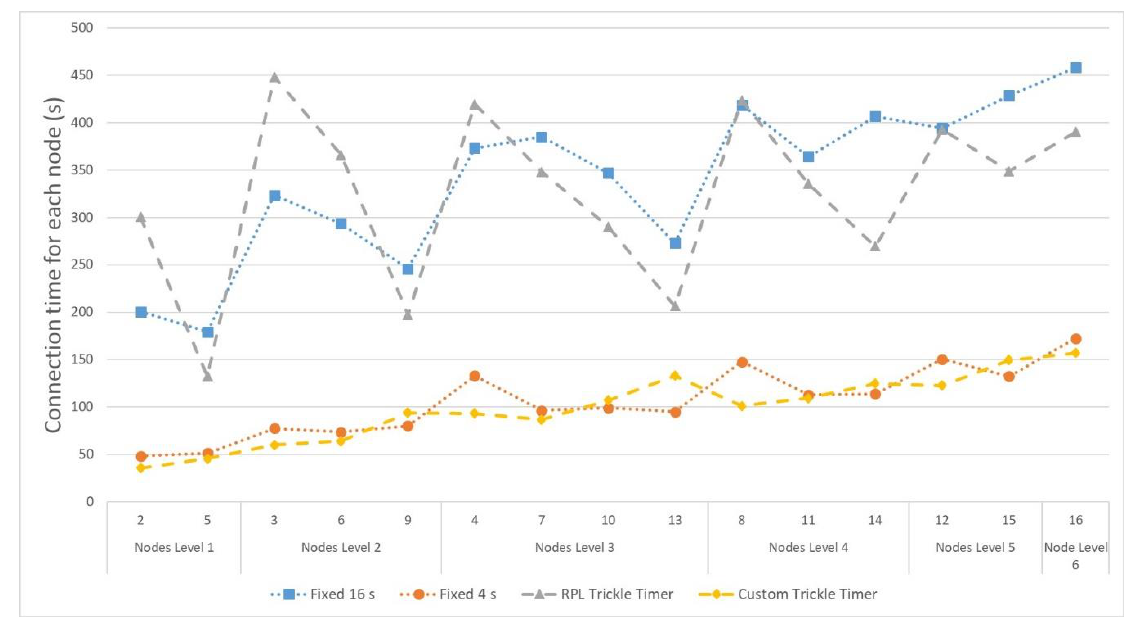
Figure 12 . The connection time for different EB period configurations. Figure 12. The connection time for different EB period